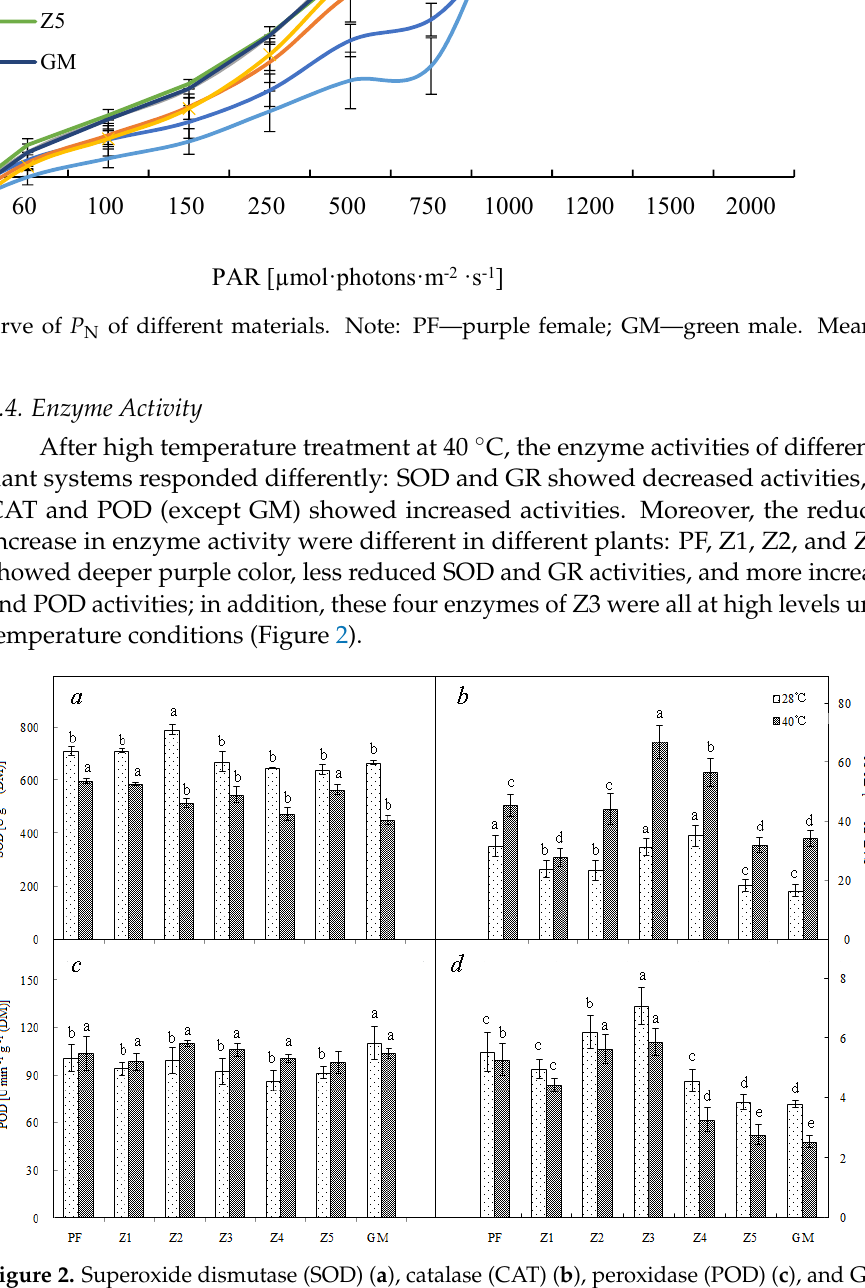
Figure 2. Superoxide dismutase (SOD) ( a ), catalase (CAT) ( b ), peroxidase (POD) ( c ), and Glutathi- one reductase (GR) ( d ) of different materials. Note: PF—purple female; GM—green male. Lowercase means significance at 0.05 levels. Means of 10 replications ± SE.